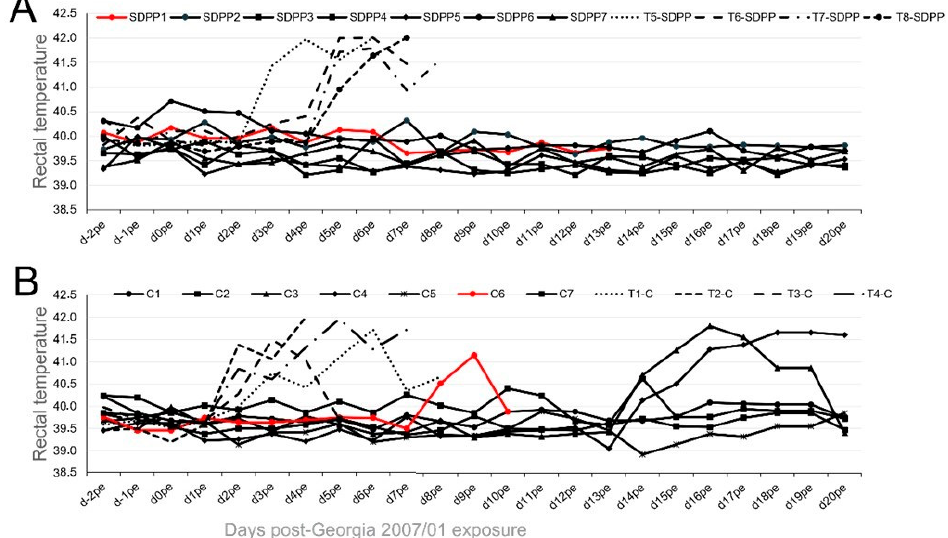
Figure 2. Rectal temperature recorded individually after Georgia 2007/01 exposure of pigs intranasally inoculated with 10 5 PFU of BA71 ∆ CD2. Data from pigs fed ( A ) the SDPP diet (SDPP1-7 pigs) or ( B ) the conventional diet (C1–C7 pigs). T1–T8 (dashed lines): Trojan pigs used for the direct contact challenge. In red color, animals that died before the end of the study. A proportion of pigs vaccinated with 10 5 PFU intranasally and fed the conventional